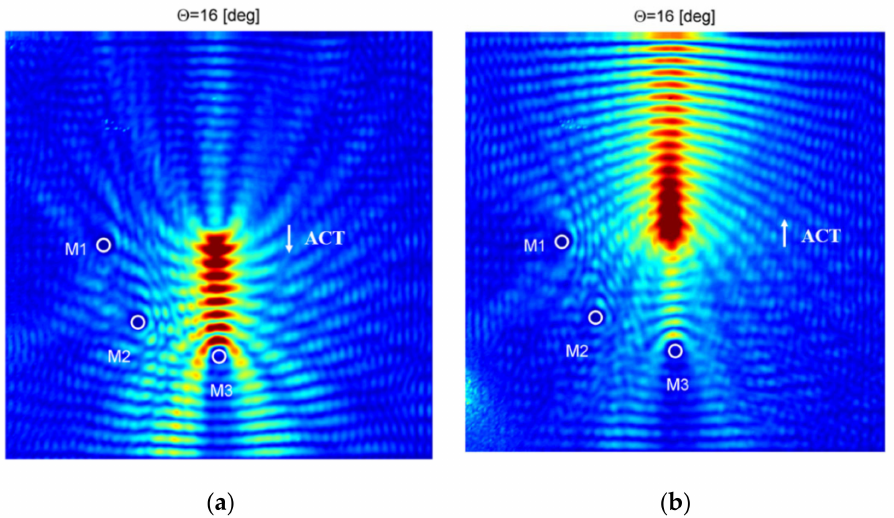
Figure 16. RMS energy map for the plate with discontinuities; ACT oriented at θ = 16 ◦ (along reinforcing fibers) and directed to: ( a ) bottom part of the plate, ( b ) the top part of the plate.